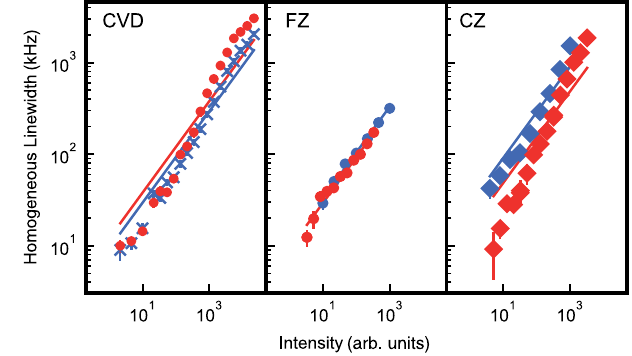
FIG. 11. Homogeneous linewidth comparison. In all samples, the homogeneous linewidth is limited by power broadening, even at the lowest powers that give a sufficient